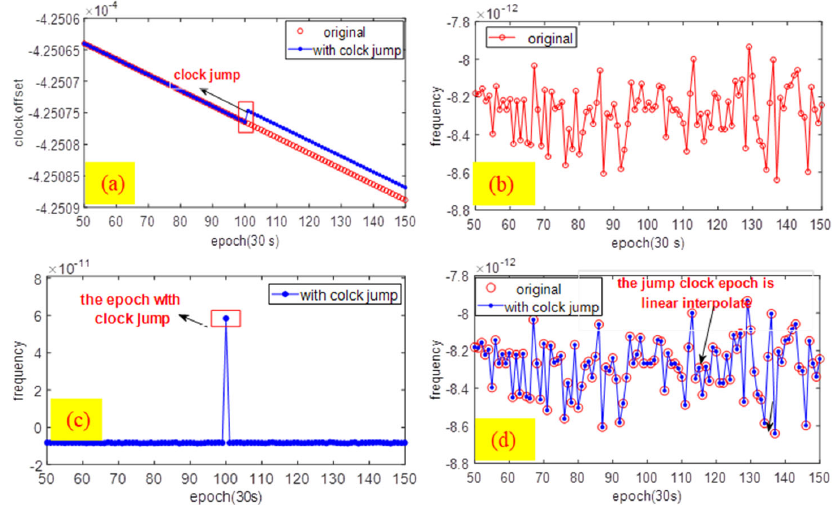
Figure 1. The clock offset and frequency series in the situation of clock jump.